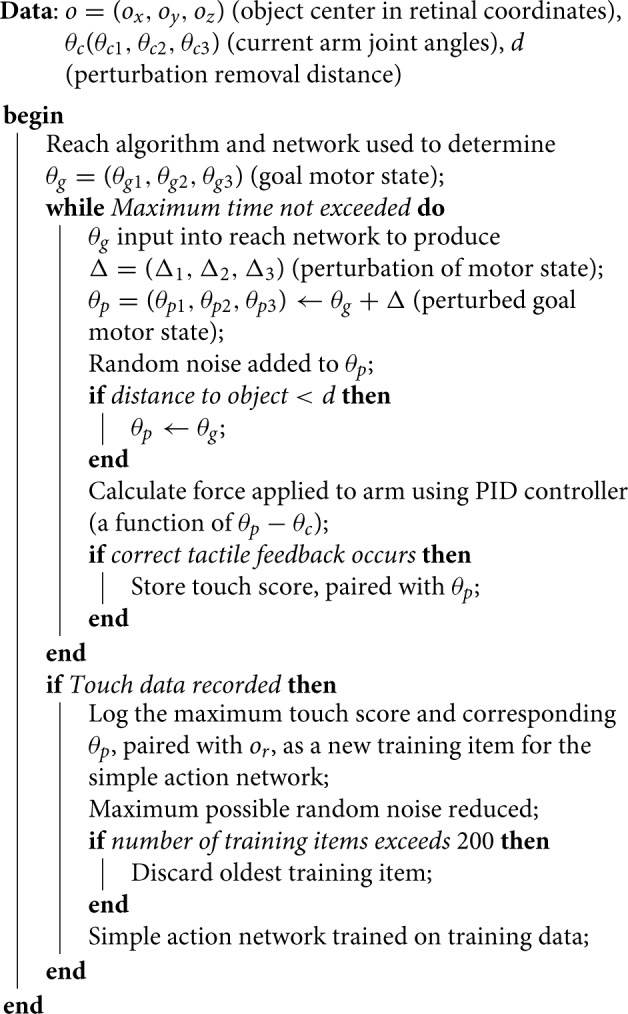
Learning simple motor programs.